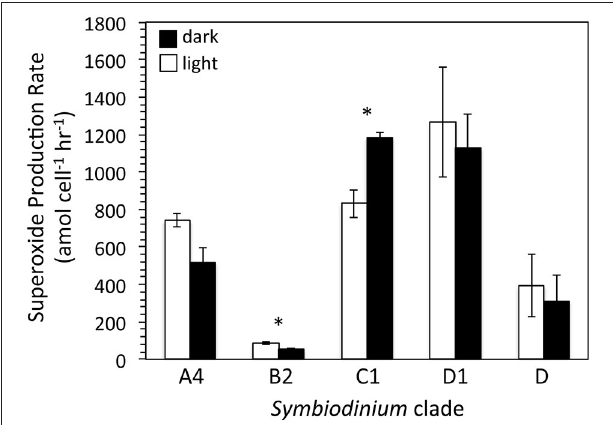
FIGURE 4 | Cell normalized extracellular superoxide production rates (mean ± SEM; n = 3, except for clade D n = 2) by five different strains of Symbiodinium , including CCMP2456 (clade A4), CCMP3364 (clade B2), CCMP2466 (clade C1), CCMP3408 (clade D1), and CCMP2556 (clade D). Measurements were conducted mid-day, either in the light (white bars; PAR = ∼ 50 µ mol photon m − 2 s − 1 ) and in the dark (black bars; PAR = 0 µ mol photon m − 2 s − 1 ). Significant differences ( p < 0.05) between day and night superoxide concentrations are indicated by an